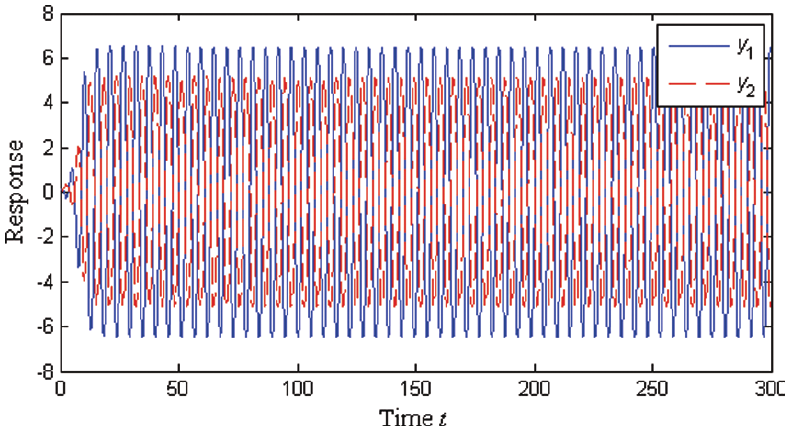
Fig. 19. Time history, Ω = 2 . 3 , ( y 1 ,y 2 , ˙ y 1 , ˙ y 2 ) = (0.1,0.1,0,0), f =